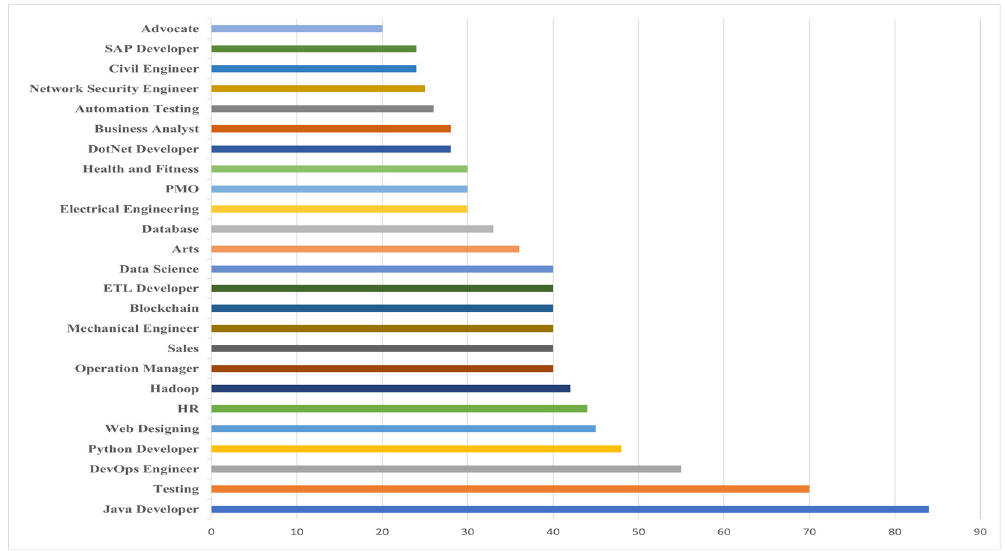
Fig. 2: Resume instances for each job category Table 1: Resume Instance for each